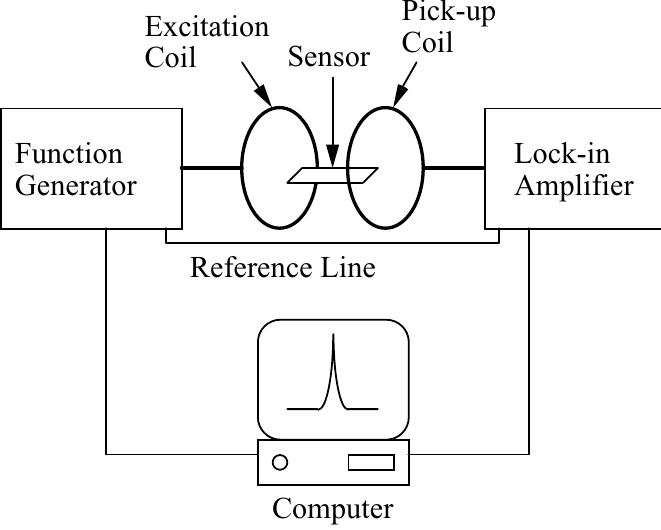
Figure 7. The frequency-domain detection system. A function generator is used to excite the sensor, and the response of the sensor is recorded via a lock-in